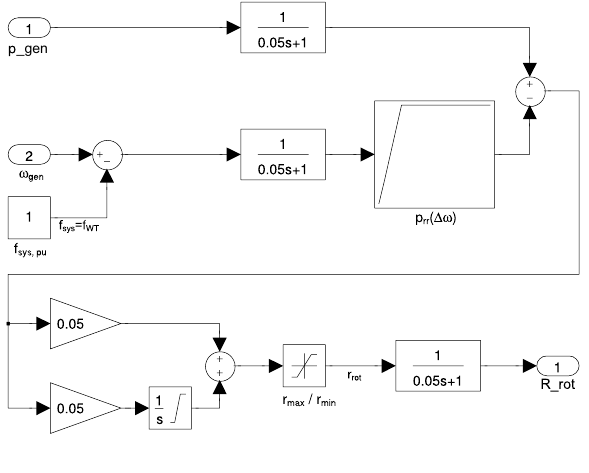
Figure 13. Rotor resistance control model.